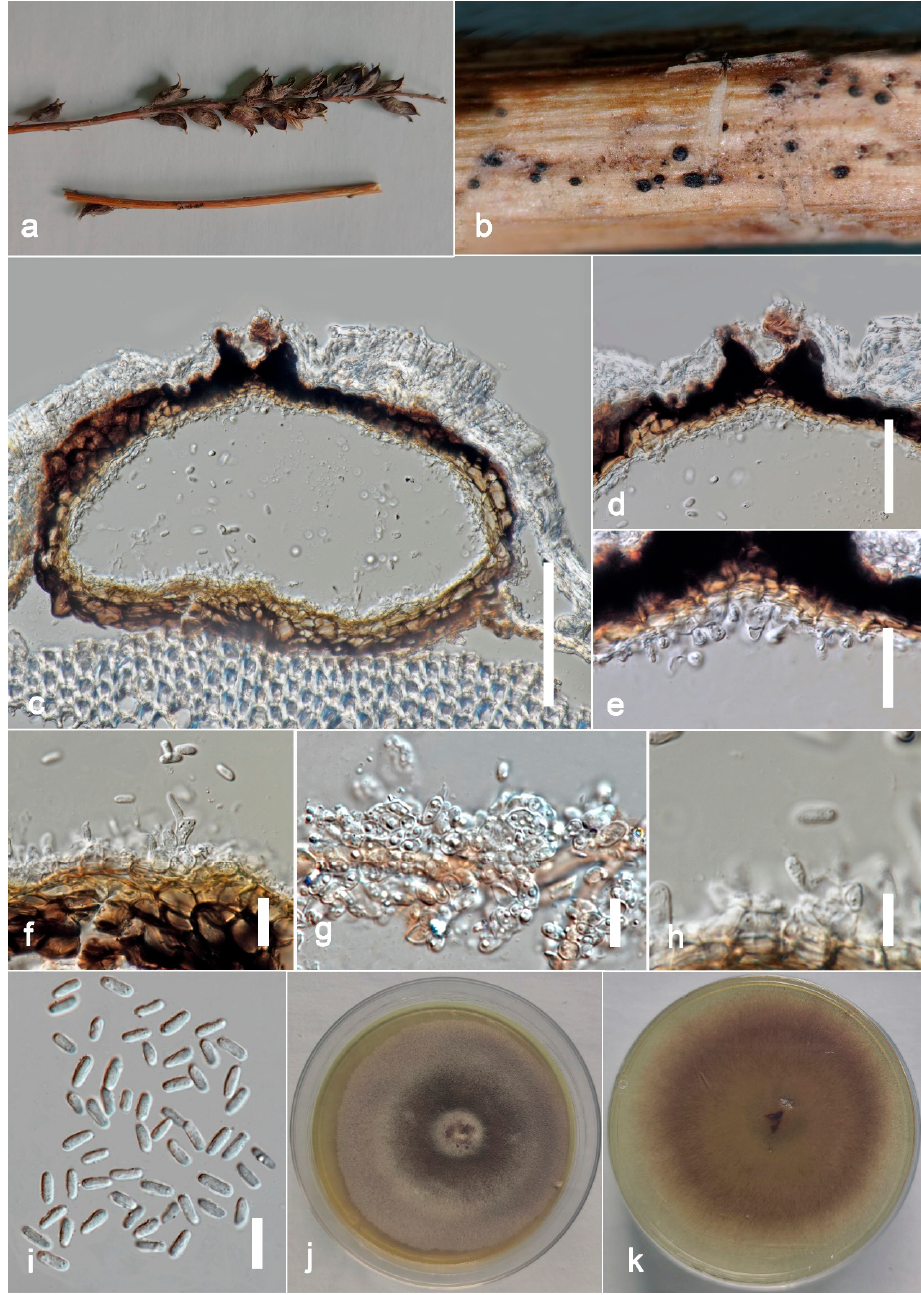
Figure 8. Stagonosporopsis pedicularis - striatae (ZHKU 22-0097, holotype ). ( a ) Host. ( b ) Material examined. ( c ) Vertical section of a conidioma. ( d ) Papilla. ( e , f ) Conidiogenous cells attached to conidia. ( g , h ) Conidiogenous cells. ( i ) Conidia. ( j ) Colony on PDA ( k ) from the bottom. Scale bars: c = 100 µ m, d = 40 µ m, e – i = 10 µ